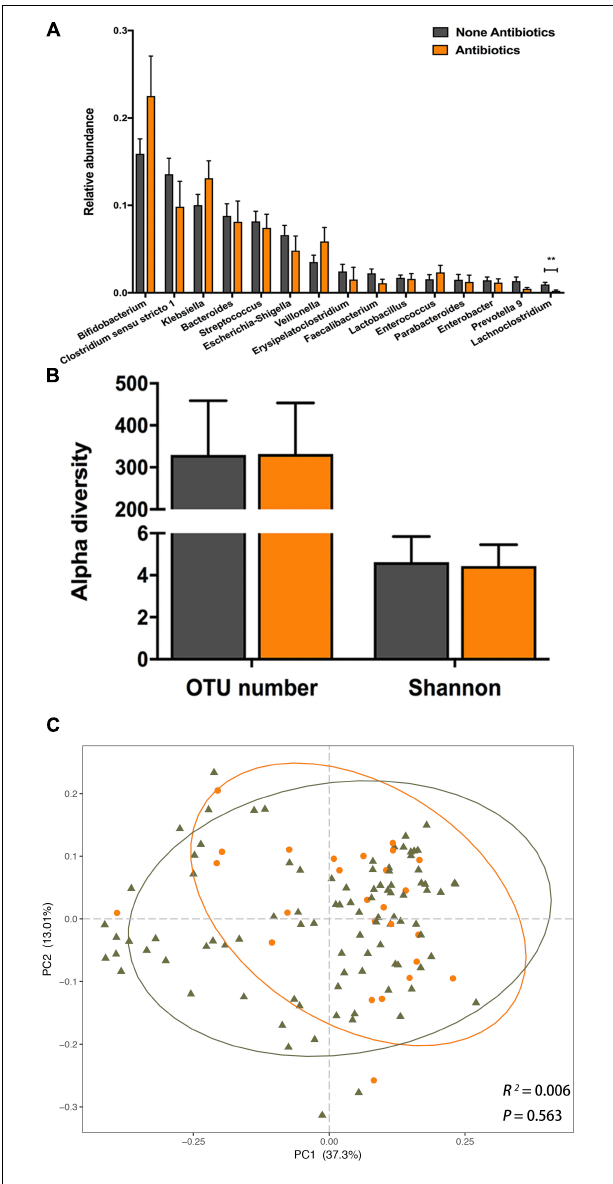
FIGURE 4 | The impact of postnatal antibiotic exposure on the infant gut microbiota. (A) Comparison of relative abundance of the top 15 genera between antibiotic exposed and unexposed infants. Significant difference was determined by Mann-Whitney U -test ( ∗∗ p < 0.01). (B) Comparison of alpha diversity between antibiotic exposed (orange) and unexposed (dark gray) infants. (C) Principal coordinates analysis (PCoA) based on weighted UniFrac distances is shown along the first two principal coordinate (PC) axes with Adonis p -value. Percentages are the percent variation explained by each PC axis. Individual samples are represented by orange points (antibiotic exposed) and dark gray triangles (antibiotic unexposed).